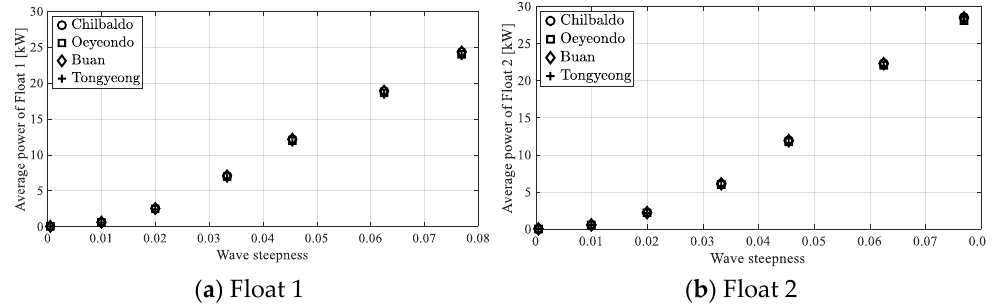
Figure 15. Comparison of the Pitch RAO assessed using linear and weakly-nonlinear analysis according to the wave steepness.